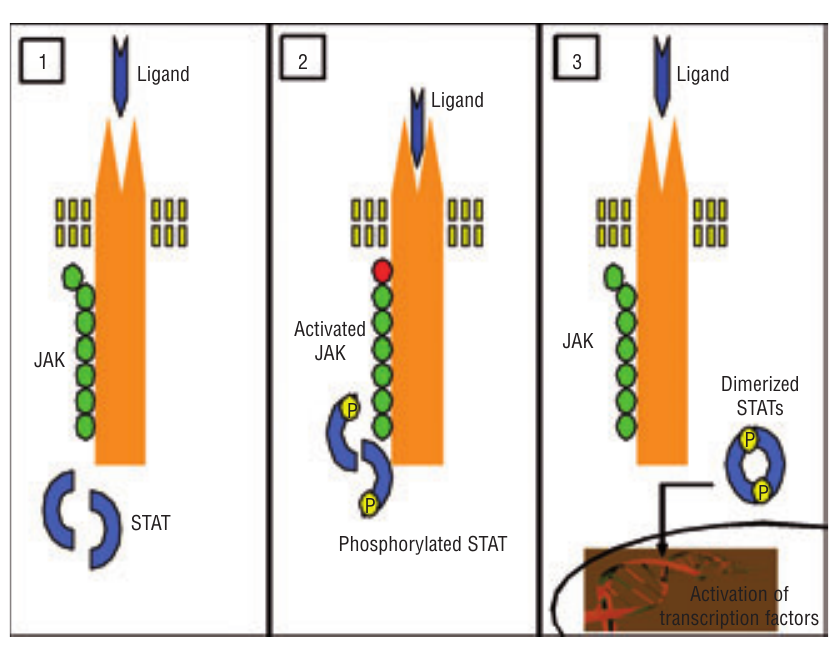
Figure 4. Steps of JAK-STAT